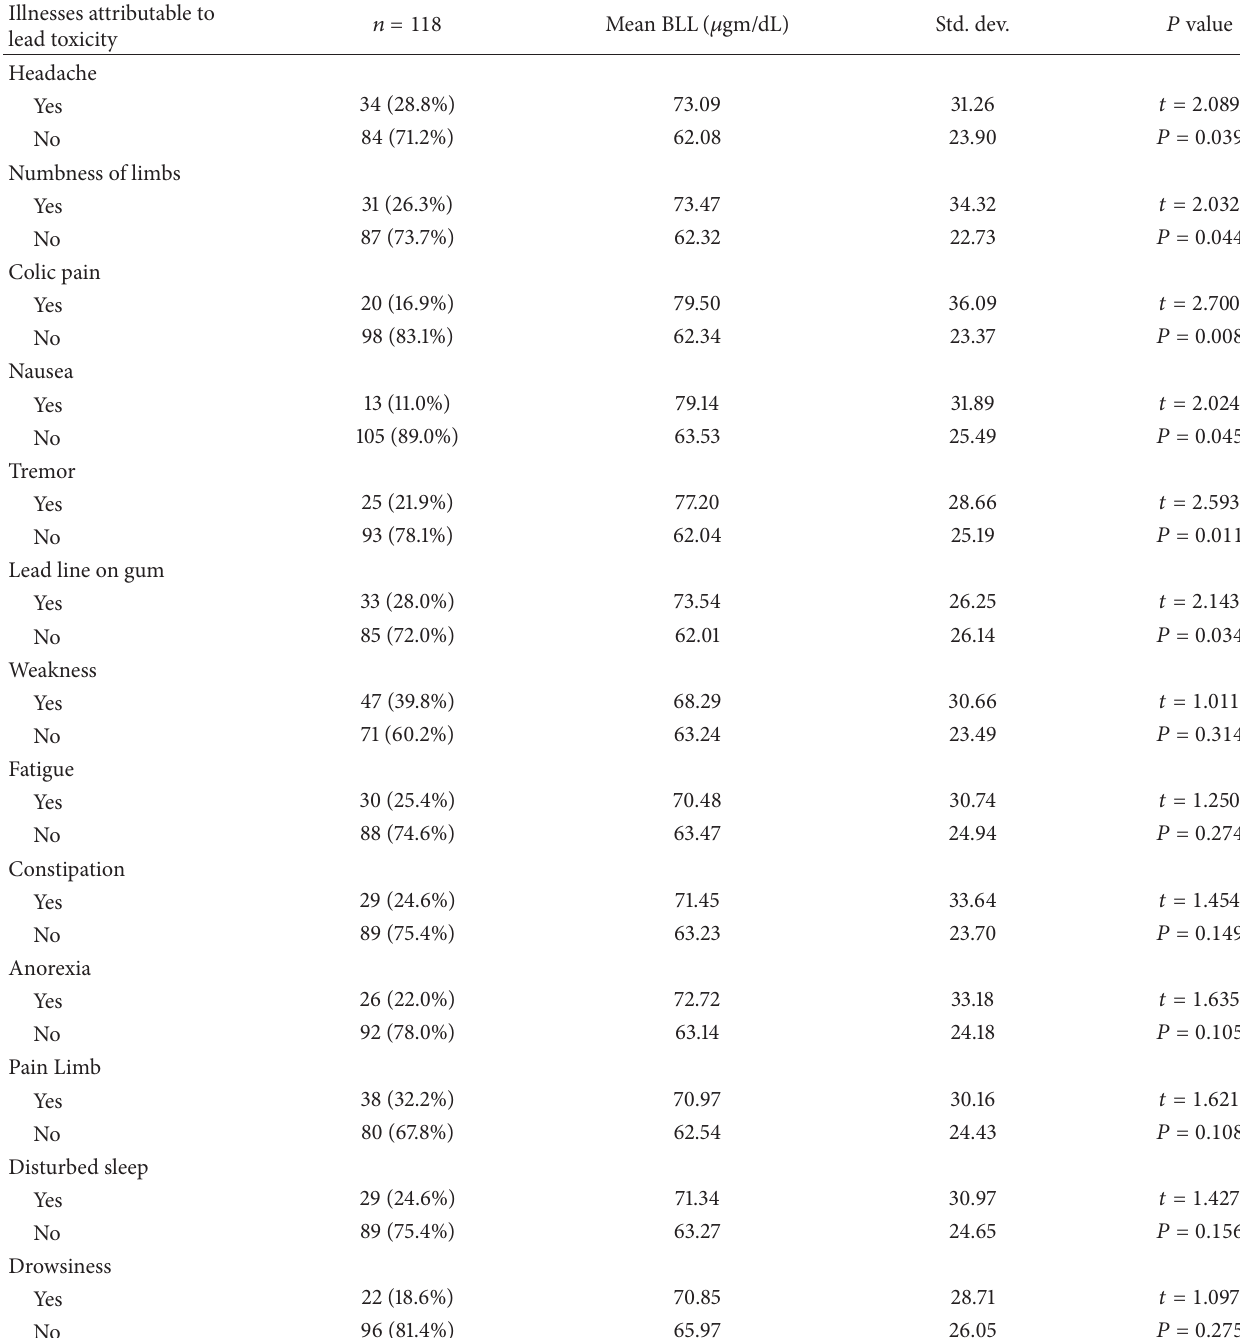
Table 3: Illnesses attributable to lead toxicity and mean blood lead level of